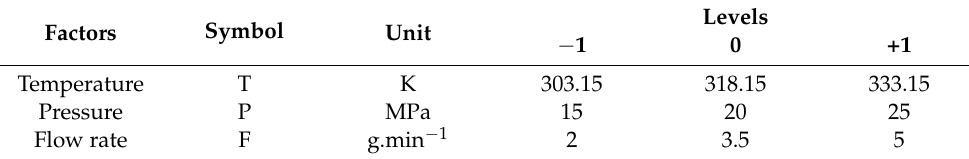
Table 6. Box–Behnken experimental design of a three-variable system.